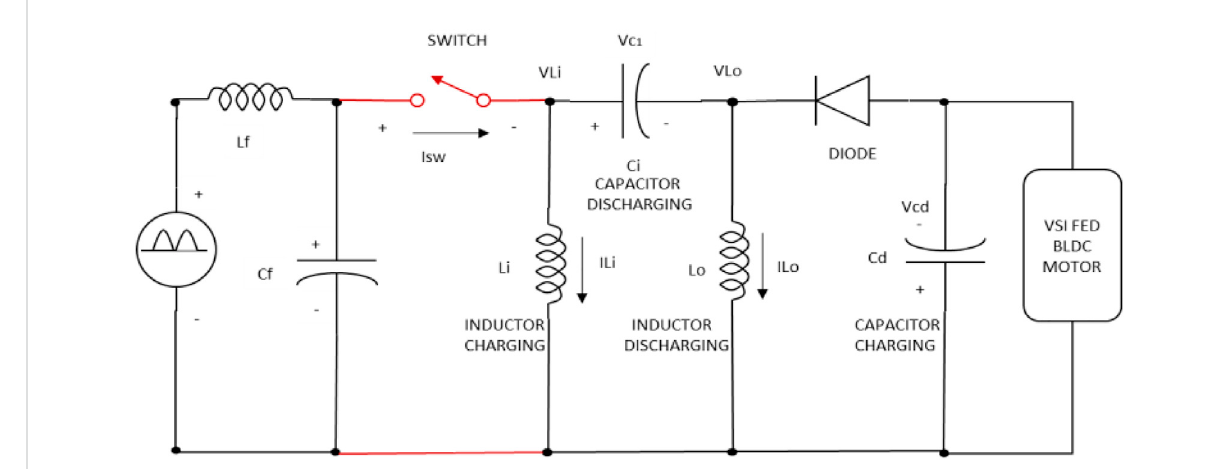
FIGURE 6 Mode 3 of modi fi ed Zeta converter.